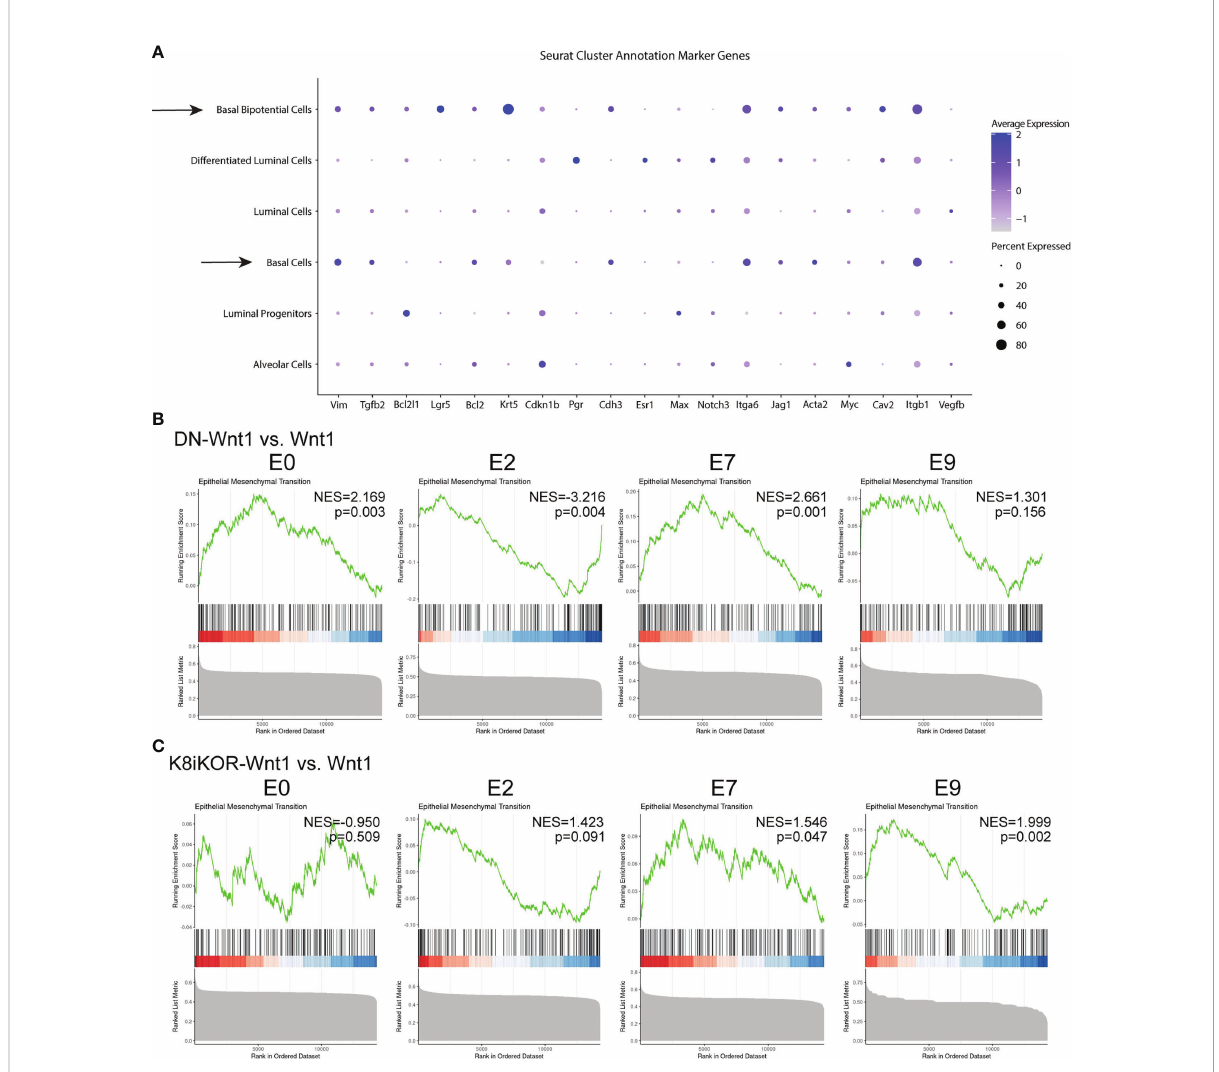
FIGURE 6 A metastatic and EMT phenotype is enhanced in tumors with reduced IGF1R. (A) Dot plot from all tumors of alignment with metastatic signature. Arrows depict clusters with high expression of markers indicating metastatic cell type. (B, C) GSEA plots for epithelial mesenchymal transition (EMT) hallmark signature in DN-Wnt1 vs. Wnt1 (B) and K8iKOR-Wnt1 vs. Wnt1 (C) for luminal clusters E0 and E7, basal cluster E2, and bipotential basal cluster E9. NES = normalized enrichment score. P values for each comparison are shown on each plot. Nominal p-value was calculated using 1000 permutations, with FDR